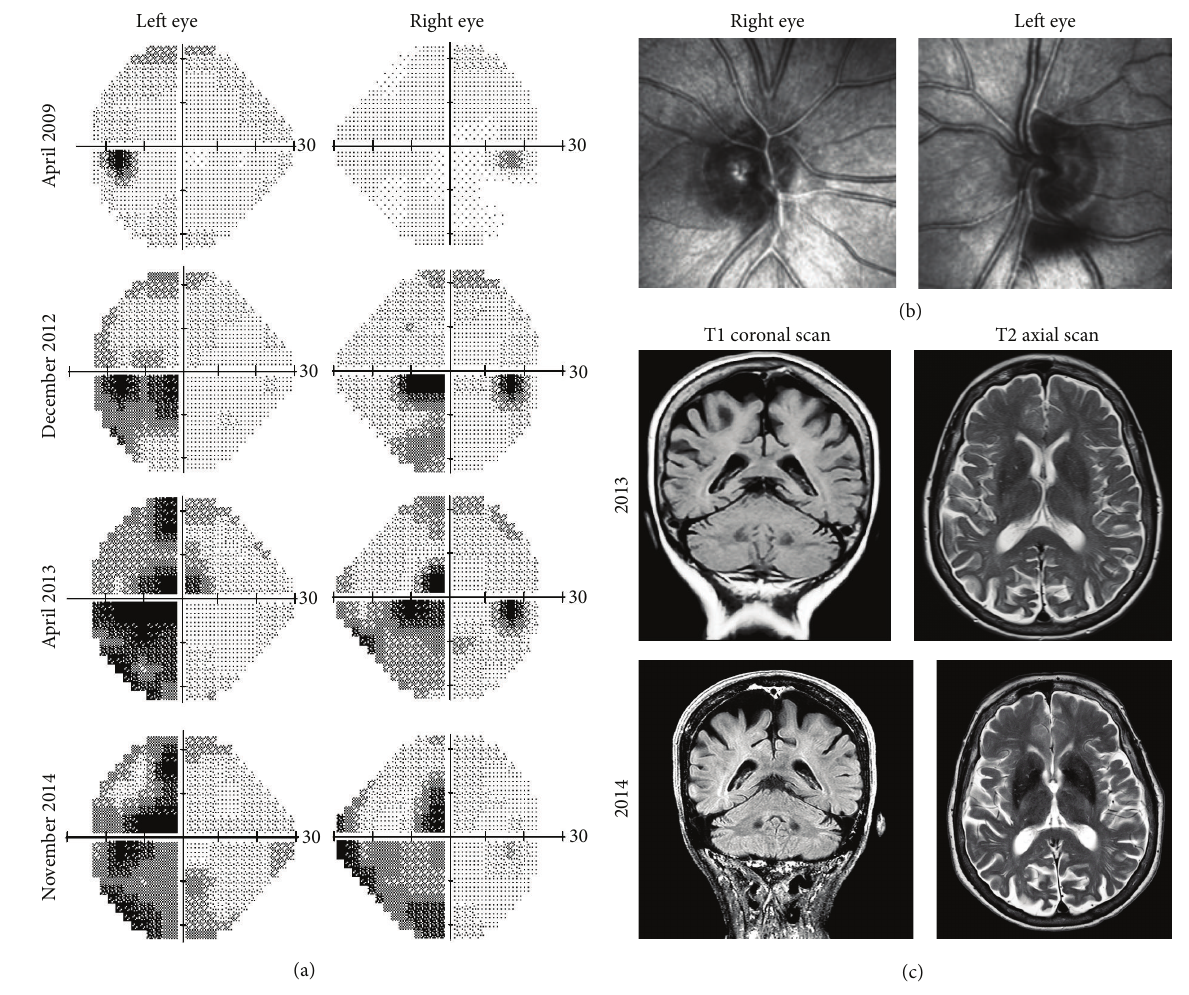
Figure 1: (a) Serial Humphrey visual fields from April 2009 to November 2014 showing progression of superior arcuate defect in the left eye to left-sided incongruous homonymous hemianopia. (b) Optic nerve head imaging in 2014 using the Heidelberg retinal tomography showing no significant disc cupping. (c) Coronal and axial magnetic resonance imaging (without contrast) in 2013 and 2014 showed progressive parietal and occipital cortical atrophy. Posterior cortical atrophy was suspected only in the 2014